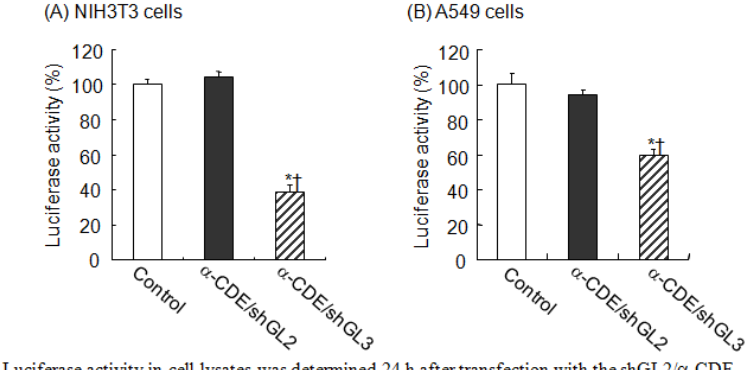
Figure 4. Sequence-specific gene-silencing effect of the complex of shGL2 or shGL3 with α -CDE (G3, DS 2) on luciferase activity in NIH3TE cells ( A ) and A549 ( B ) cells transiently expressing pGL3 luciferase